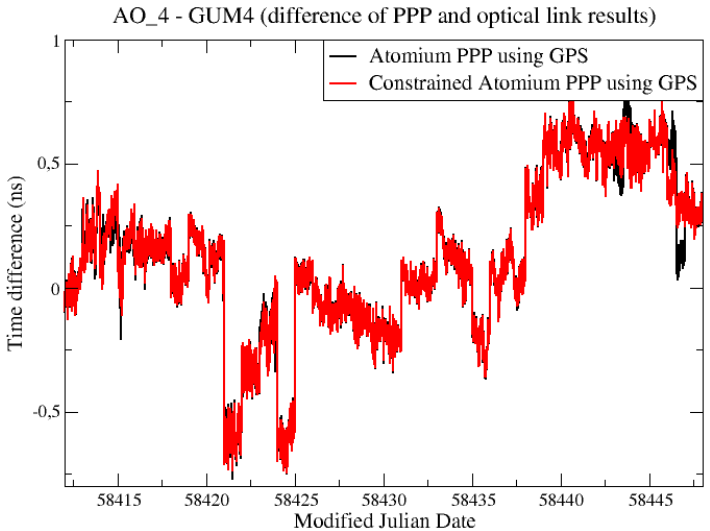
Figure 9. “PPP—OPT” experiments to evaluate constrained PPP.